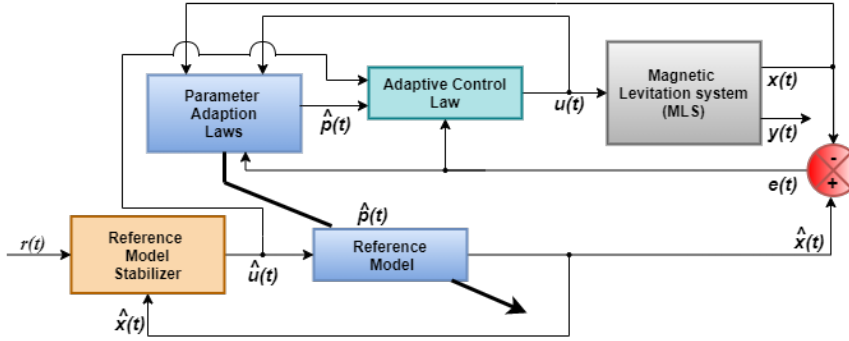
Figure 3. Model assisted adaptive control structure for Magnetic Levitation System